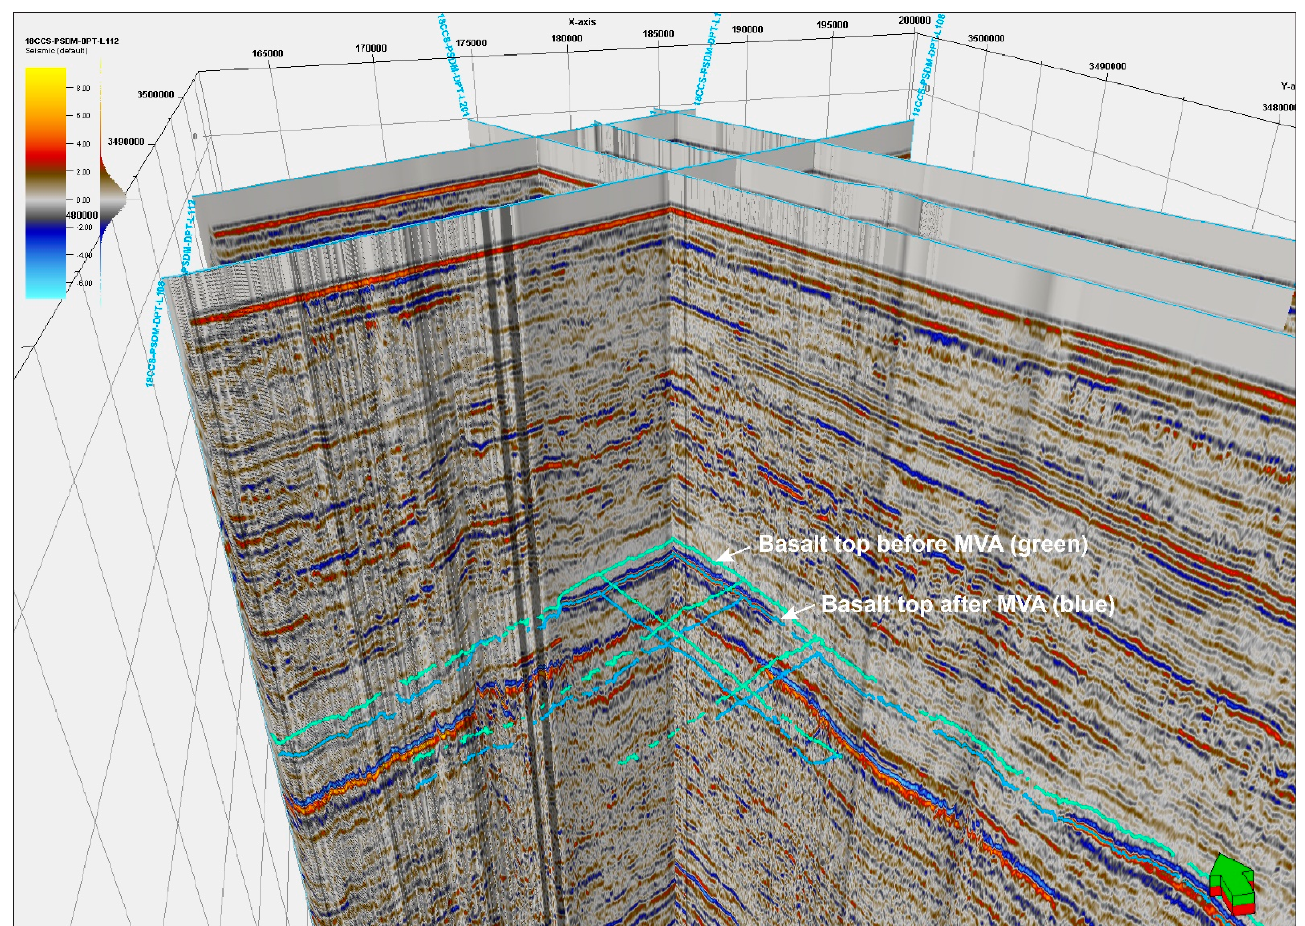
Figure 10. 3D depth-domain stack sections after applying MVA at the 3rd iteration. The green and blue lines represent the top of the basalt before and after applying MVA, respectively.